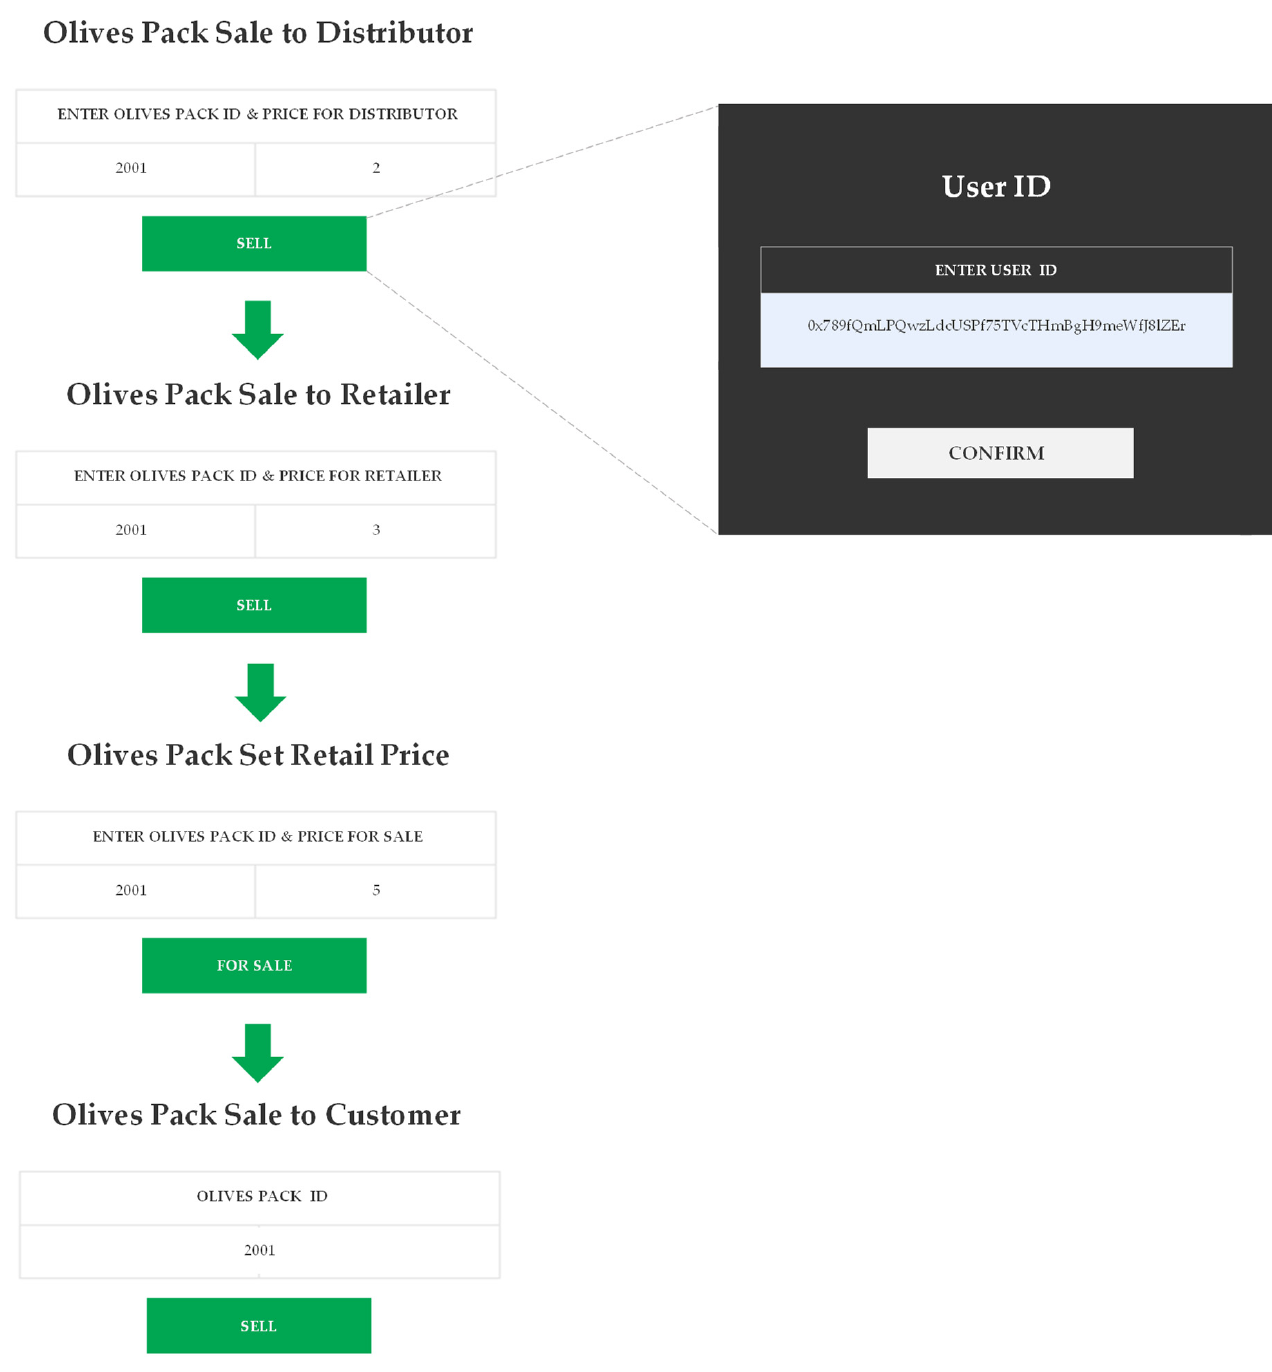
Figure 6. Selling to Distributor, Retailer, and Customer.